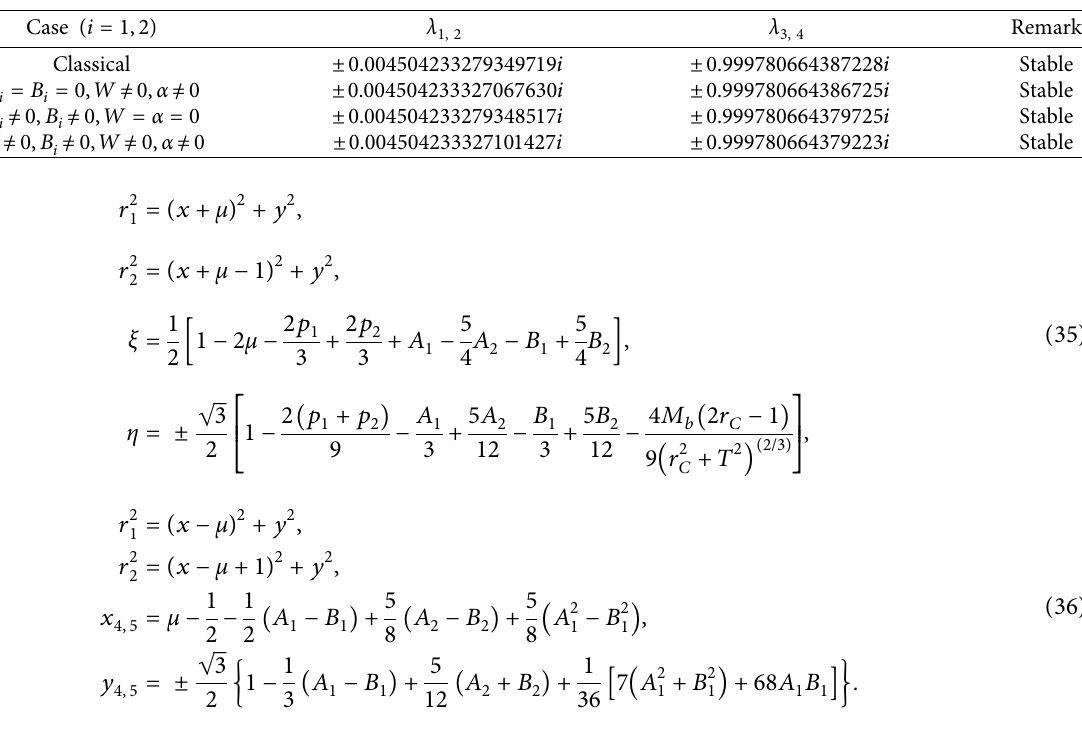
, B , W ≠ 0 , α ≠ 0 case. i ≠ 0 i ≠ 0